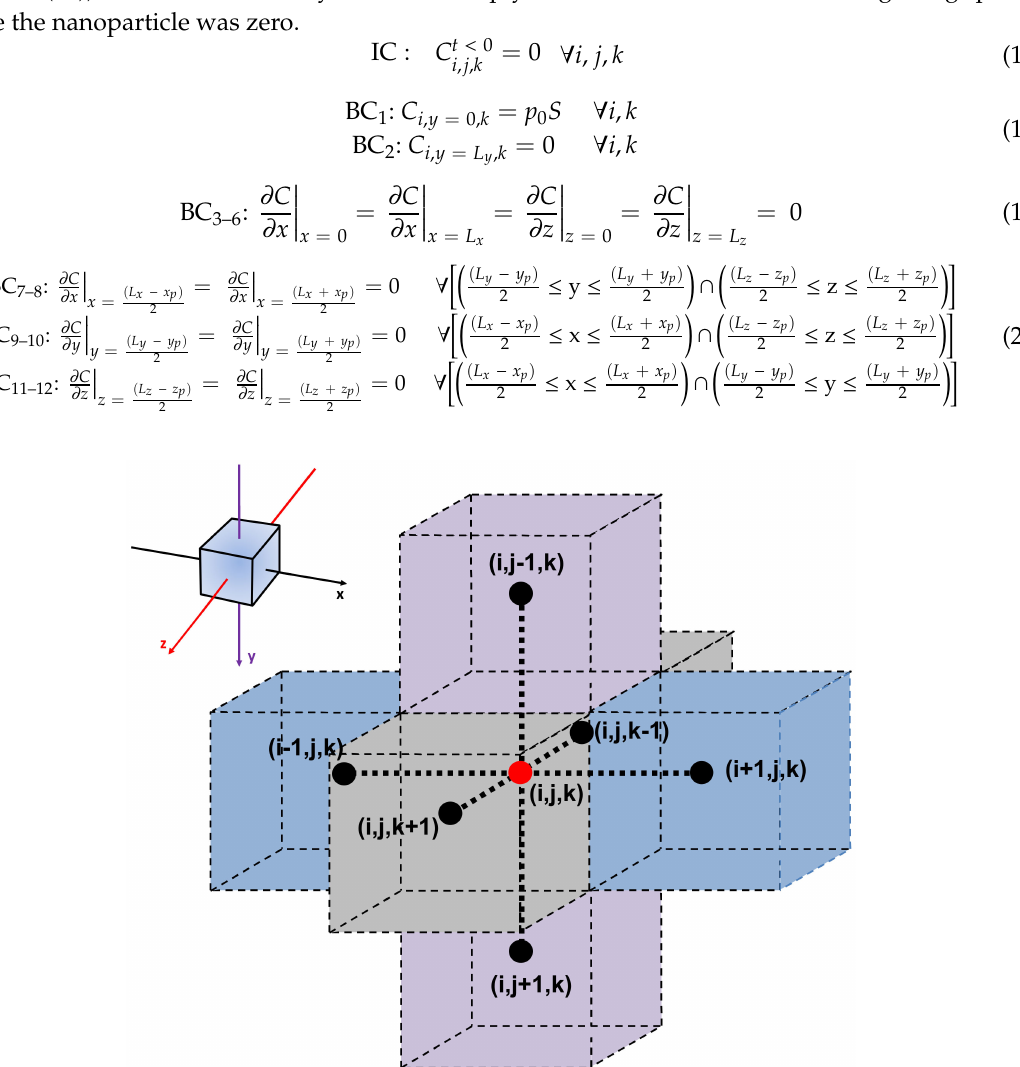
Figure 2. Nomenclature of an interior mesh point with its six neighboring mesh points. x , y , and z directions are represented by i , j , and k ,